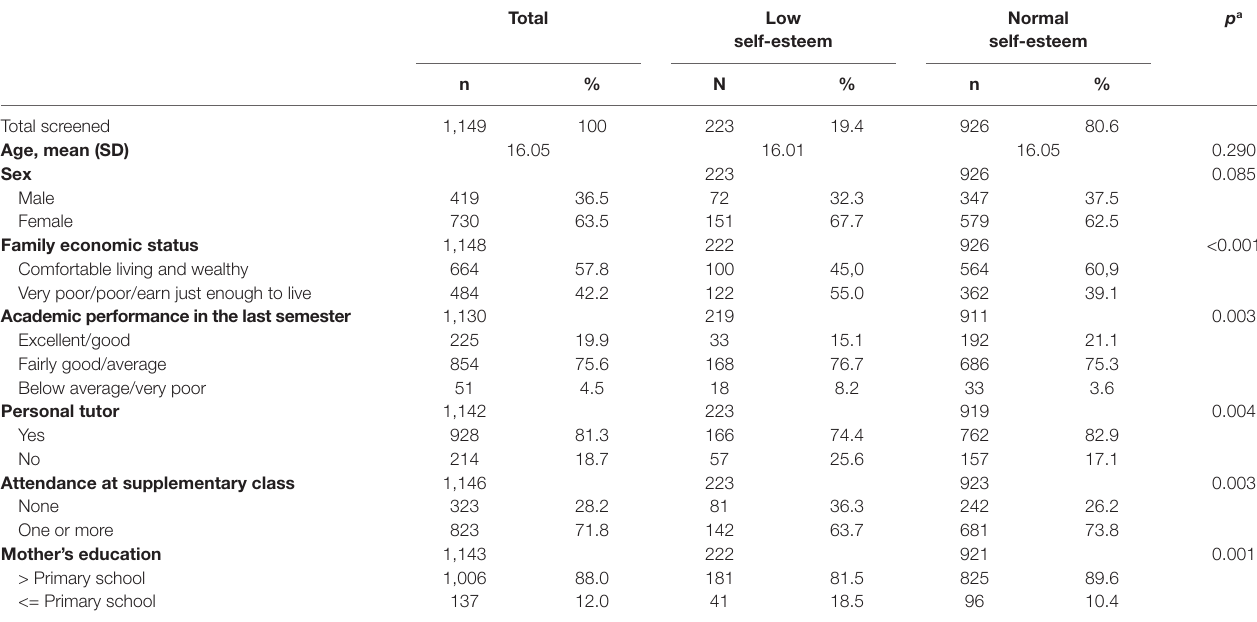
TABLE 1 | Frequencies and percentages (%) of sociodemographic variables of participants by self-esteem status. Total Low